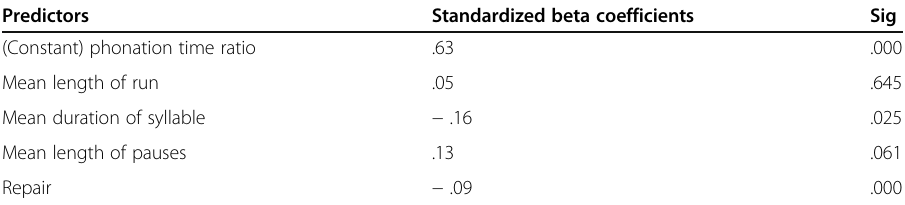
Table 10 Multiple regression